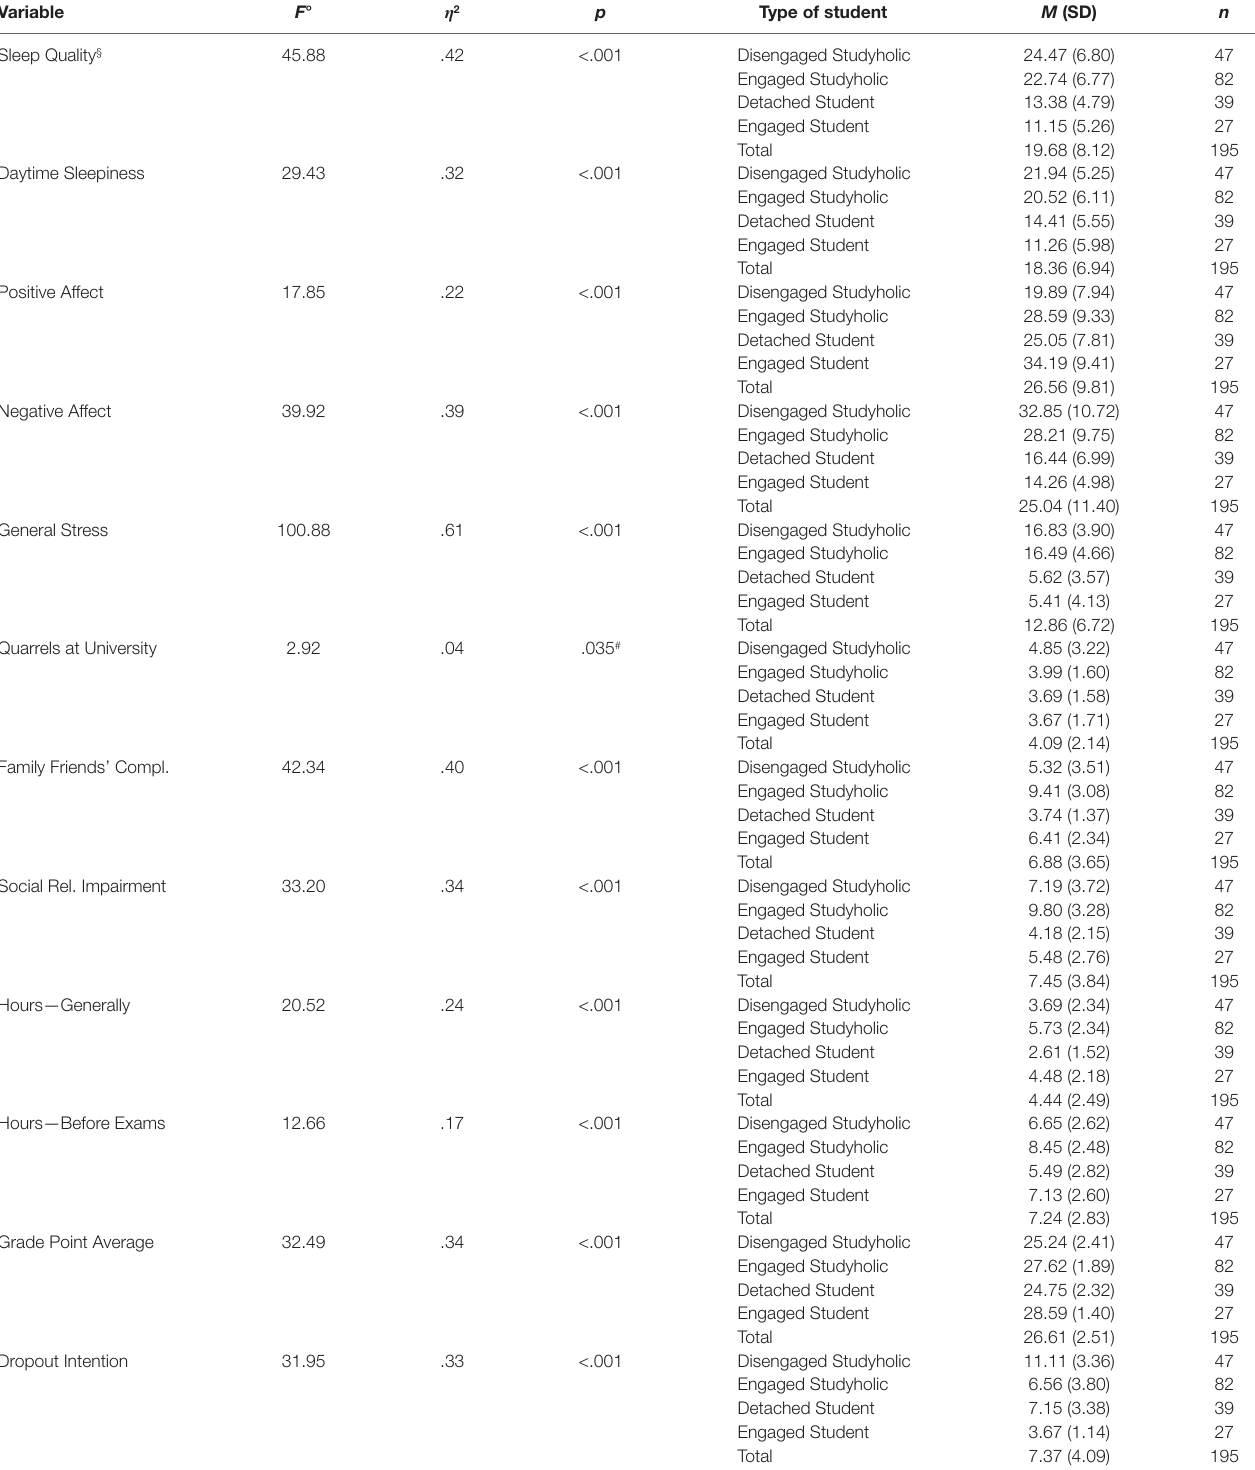
TABLE 7 | Means (SDs) and follow-up ANOVAs conducted after the MANOVA of outcomes by type of student. Variable F ° η 2 p Sleep Quality